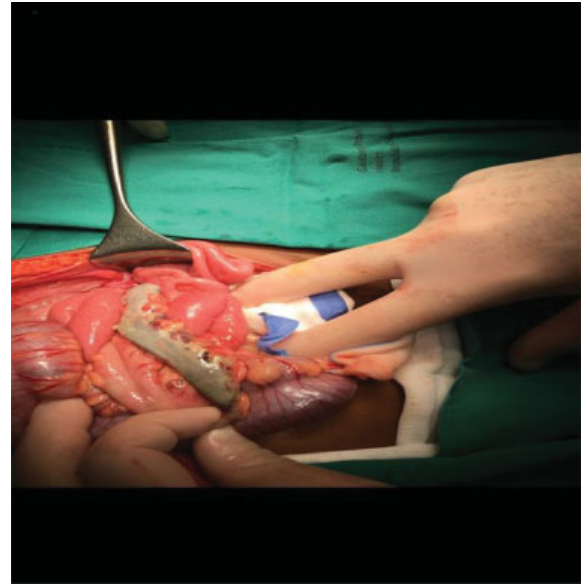
Fig. 1 A 2-year-old during the fi rst laparotomy post herbal enema administration — a necrotic rectum and sigmoid identi fi ed without any signs of perforation.